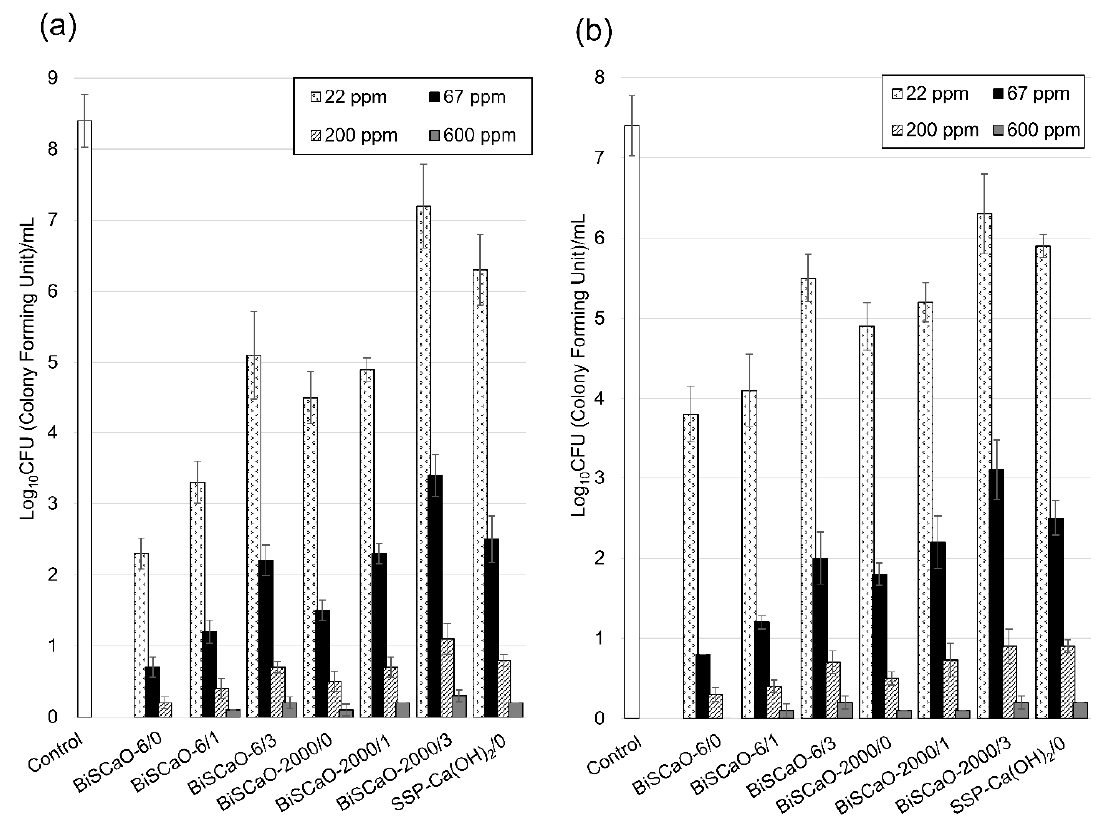
Figure 5. Microbicidal e ffi cacy of BiSCaO dispersion. The number of colony forming units (CFUs) of ( a ) total viable microbe counts (TC) and ( b ) coliform bacteria (CF) in the contaminated suspension mixed with each BiSCaO were counted after gentle vortexing three times for 30 s and incubated at room temperature for 15 min ( n = 4). Pure water as control of disinfectant was used as the control.